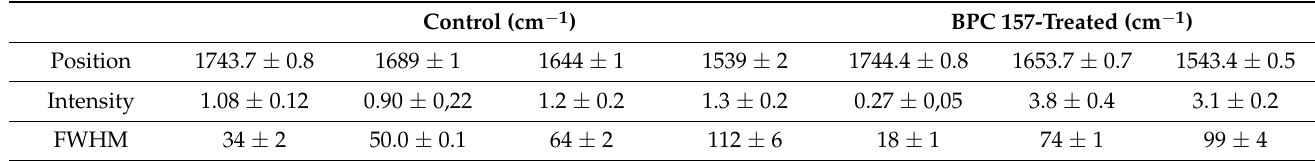
Table 3. Average vibrational band parameters obtained by